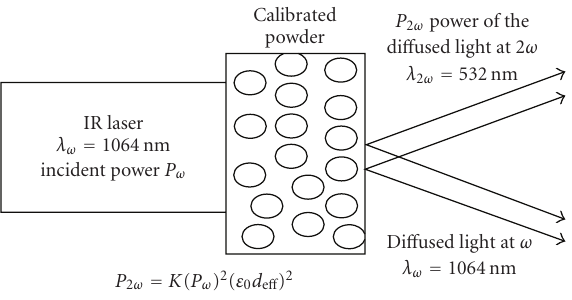
Figure 4: Principle of Kurtz-Perry powder SHG